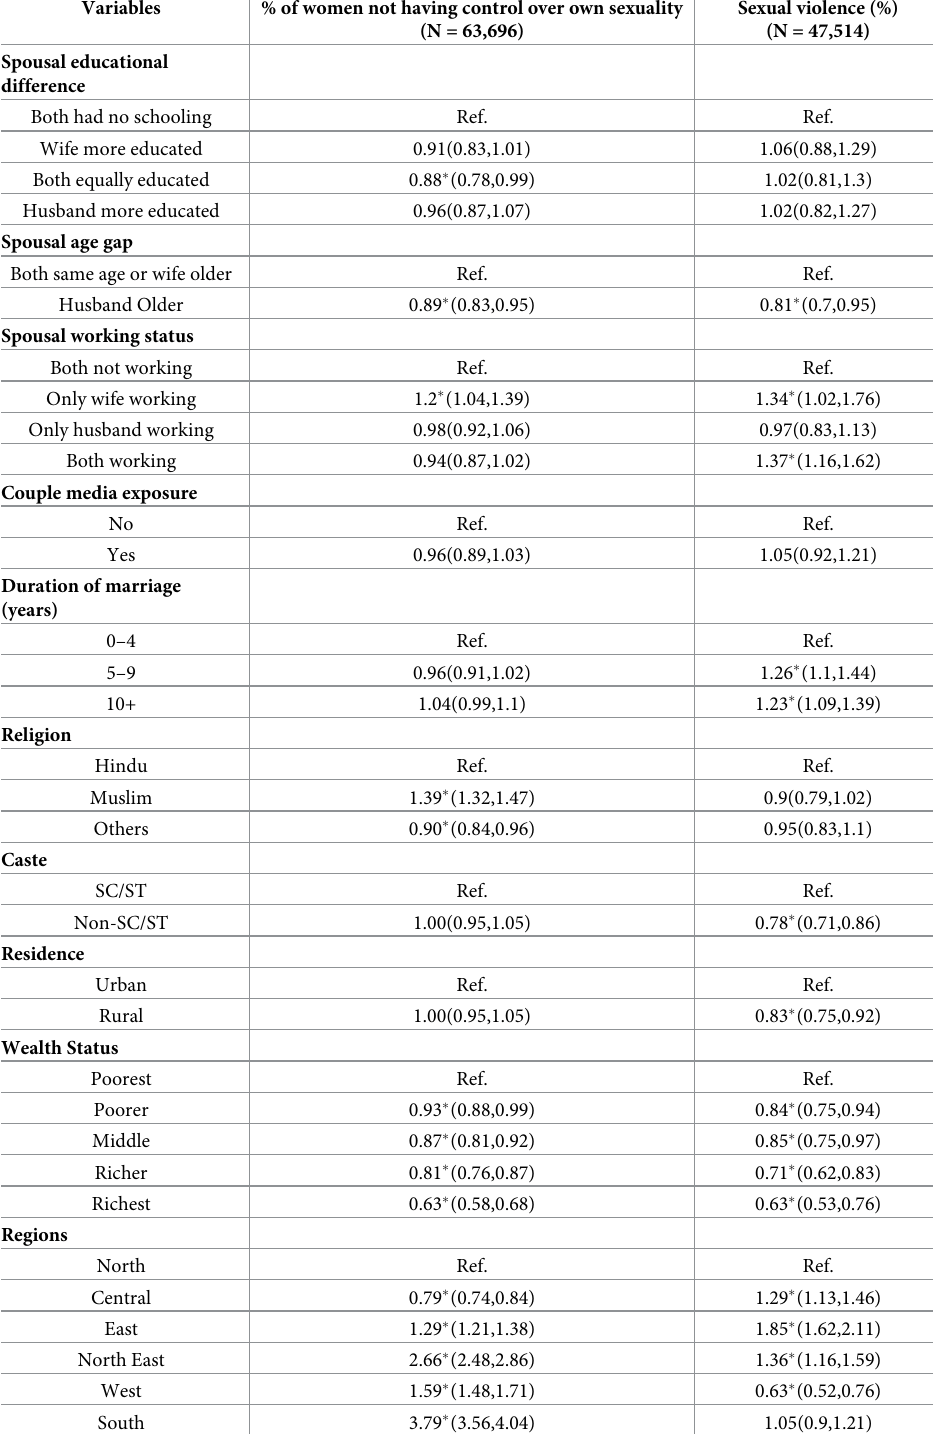
Table 3. Adjusted odds ratio of women not having control over own sexuality and experienced sexual violence by background